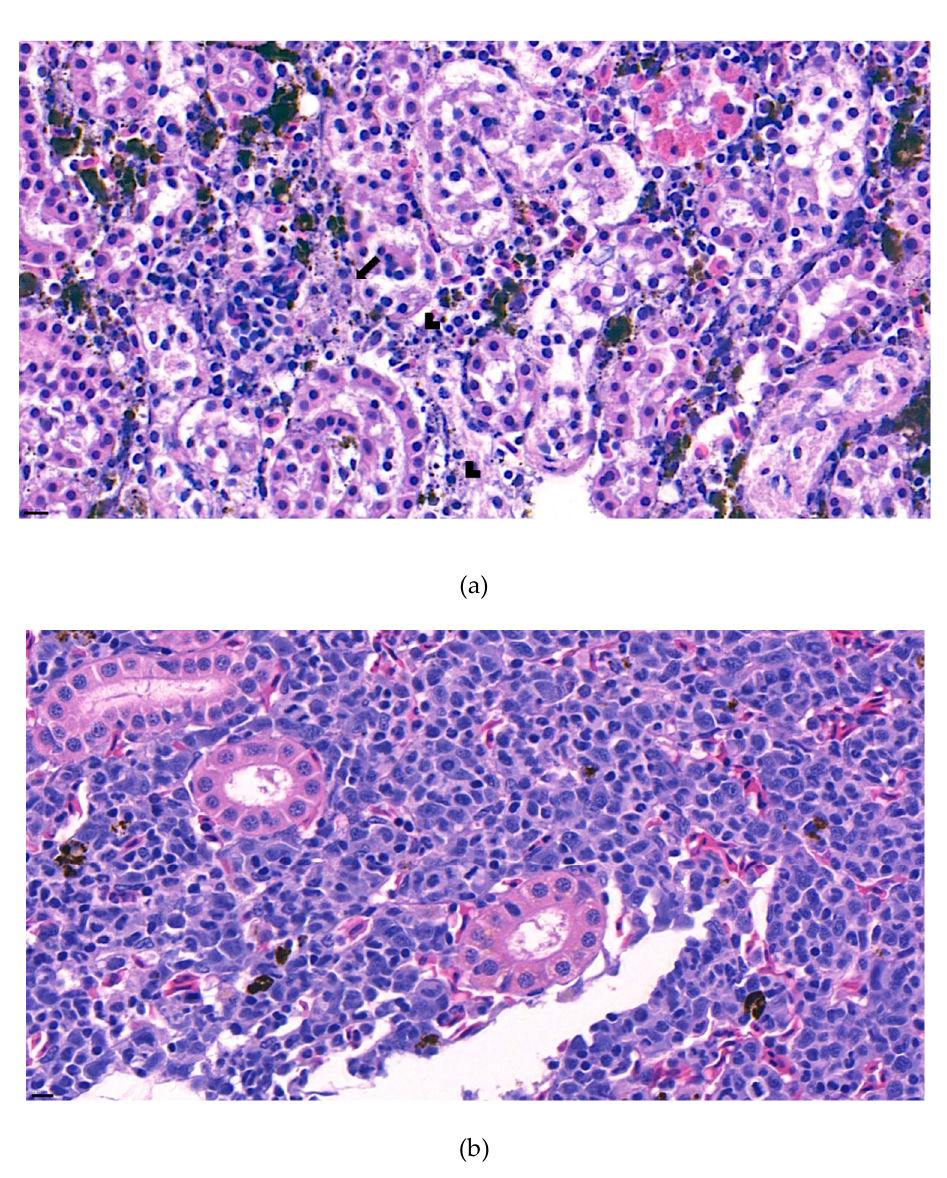
Figure 2. ( a ). Representative image of hematoxylin and eosin-stained tissue section showing degenerated tubules surrounded by lymphocytes and macrophages in the kidney of the diseased fish. Signs of phagocytized rod-shaped bacterium and cellular debris can also be observed. (arrow: phagocytized rod-shaped bacterium, arrow head: cellular debris) ( b ). Negative fish group kidney image stained with hematoxylin and eosin. (Bar indicating 10 µm).